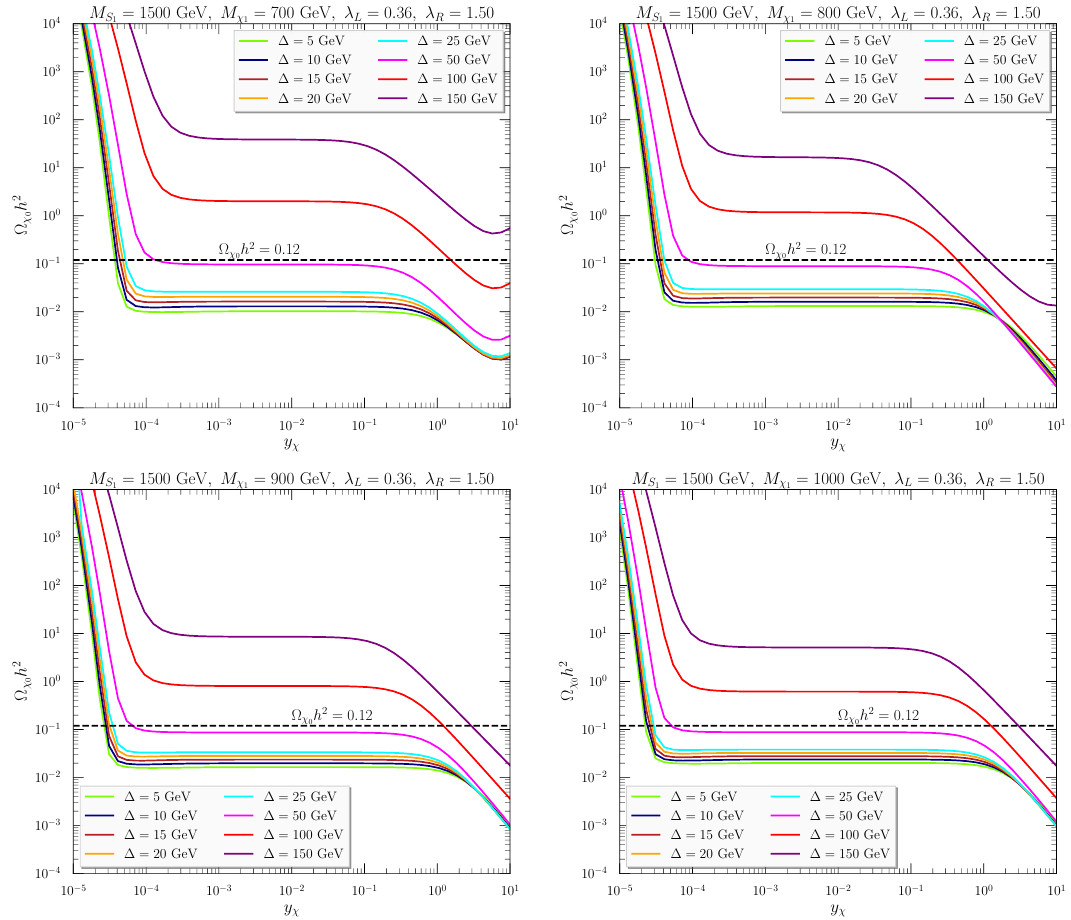
Figure 15 . The DM relic abundance as a function of y χ in BS2 scenarios for M S = 1500 GeV , λ L = 1 0 . 36 and λ R = 1 . 5 . We consider four options for the χ 1 mass consistent with constraints from missing energy searches at the LHC: M χ = 700 GeV (upper left), 800 GeV (upper right), 900 GeV (lower 1 left) and 1000 GeV (lower right). The curves in green, navy, sienna, orange, cyan, magenta, red and purple correspond to values of ∆ of 5, 10, 15, 20, 25, 50, 100 and 150 GeV